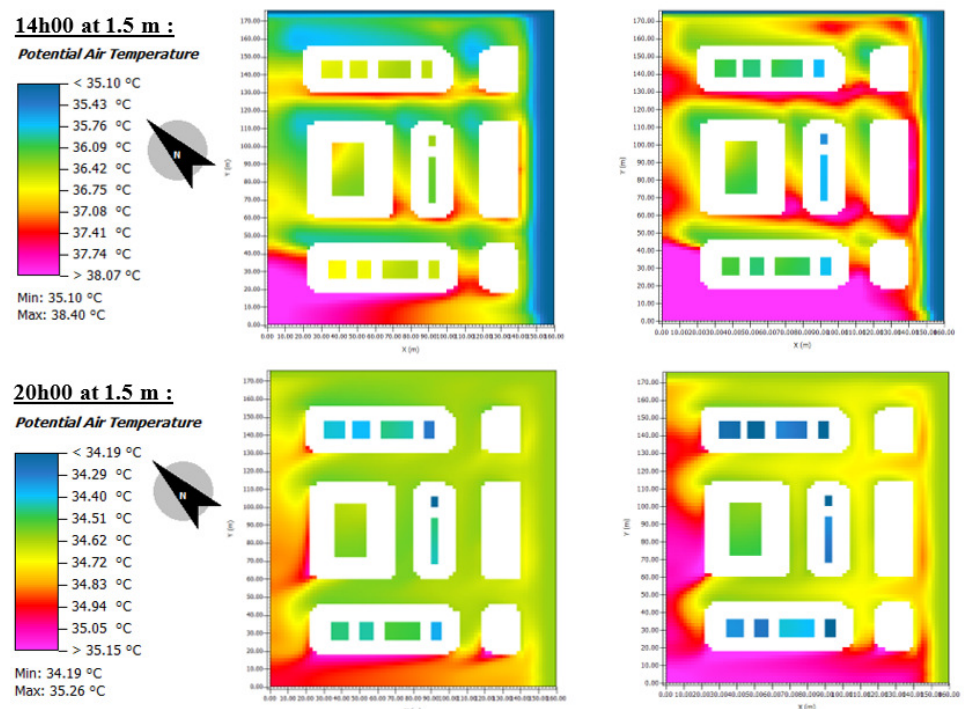
Figure 6. Comparison of the influence of red asphalt (left side) and black asphalt (right side) on the PAT at 2 pm and 8 pm using ENVI‐met